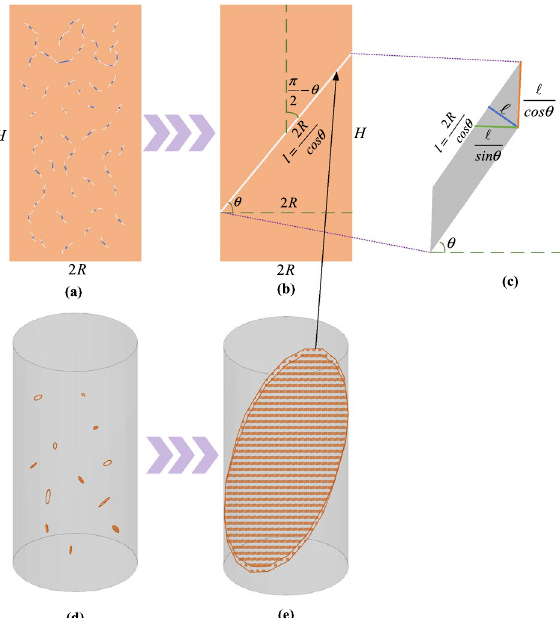
Figure 3. The transformation of the crack incremental voxel into an equivalent elliptical thin plane. ( a ) is a two- dimensional schematic of the fractured voxel; ( b ) is a front view of the transformed elliptical thin plane; ( c ) is a schematic enlargement of the elliptical thin plane; ( d ) is a three-dimensional schematic of the fractured voxel, and ( e ) is a three-dimensional schematic of the transformed elliptical thin